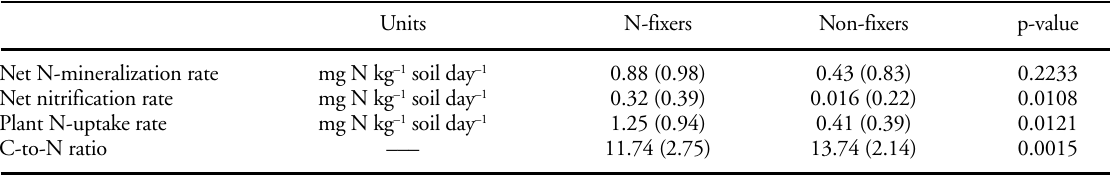
Table 2. Means and standard deviations of soil N mineralization, nitrification, and plant N uptake rates and the soil C-to-N ratio